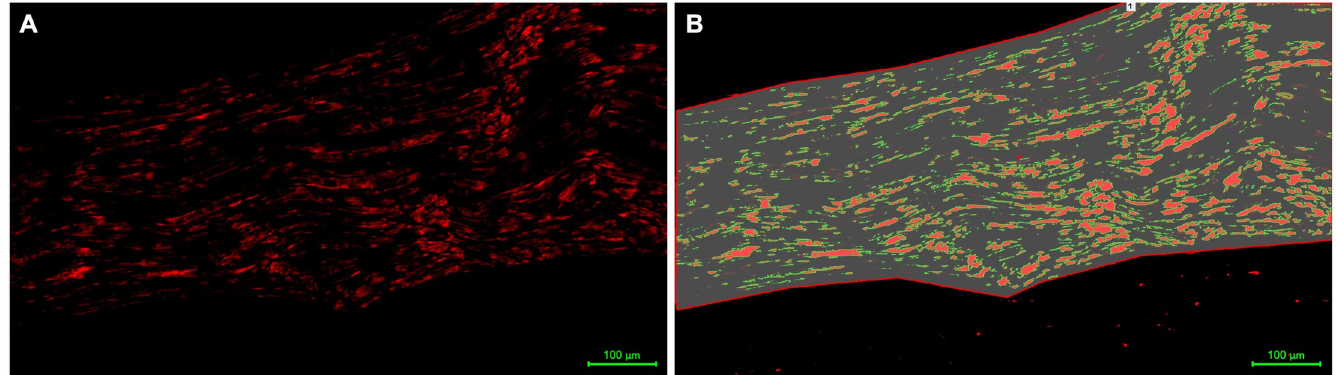
Fig 1. Analysis of immunofluorescent staining. Longitudinal sural nerve section at 20x magnification (S100 antibody; DAKO Z0311; 1:200). NIS Elements AR– Measurement Software was used to measure the intensity of immunofluorescent staining in nerve sections (A). The area fraction of immunofluorescent signals was calculated in the selected area of the image (B). Scale bar: 100 μ